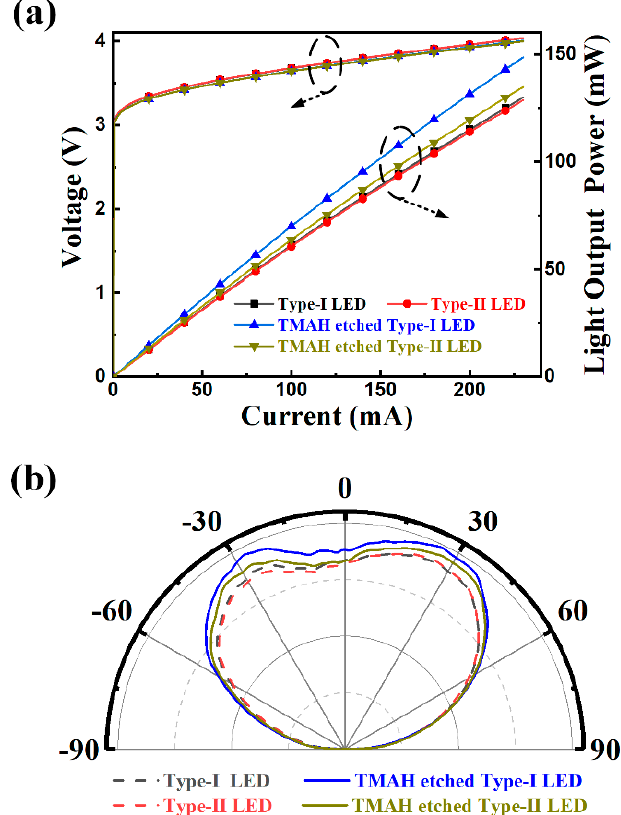
Figure 6. ( a ) L-I-V characteristics of the cuboid geometry LEDs with and without TMAH etching treatment. ( b ) Far-field emission patterns of the cuboid geometry LEDs with and without TMAH etching treatment.